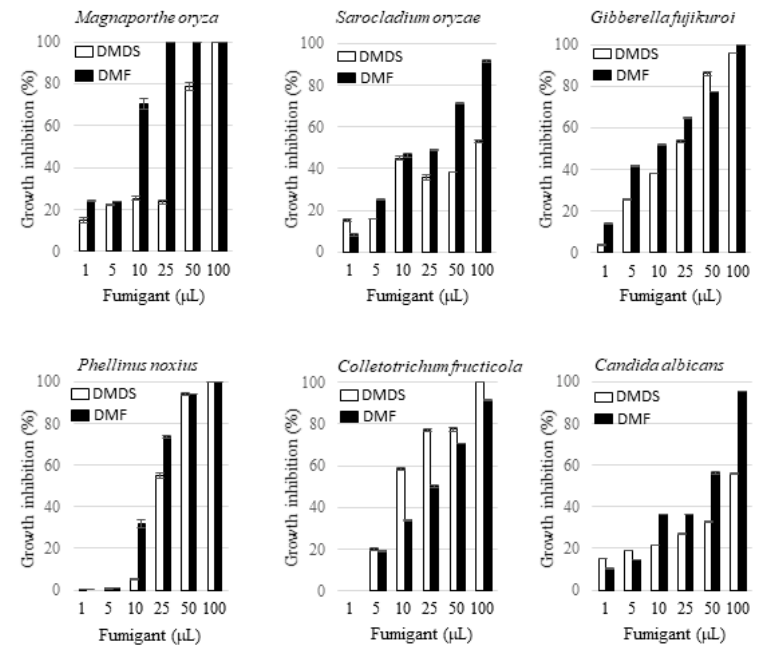
Figure 7. Antifungal activity of 2,5-dimethylfuran and dimethyl disulfide via fumigation. The fungus was cultivated on PDA or YPD in a tightly closed 125 mL Erlenmeyer flask, in which 2,5-dimethylfuran (DMF) or dimethyl disulfide (DMDS) at the indicated aliquot was included as described in Section 4. Cultivation was continued until the fungal colony in the fumigant-absent control group was fully grown. The effect of the fumigant on growth of the fungus was recorded, and the radial inhibition percentages (%) was calculated as described in Section 4. All data points are the means of three replicates.